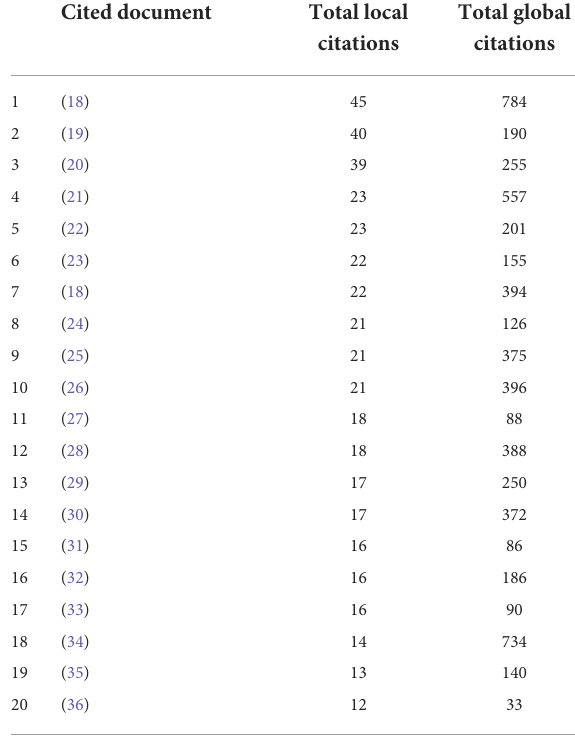
TABLE 6 The 20 most locally cited references within the anesthesiologic dataset between 2000 and